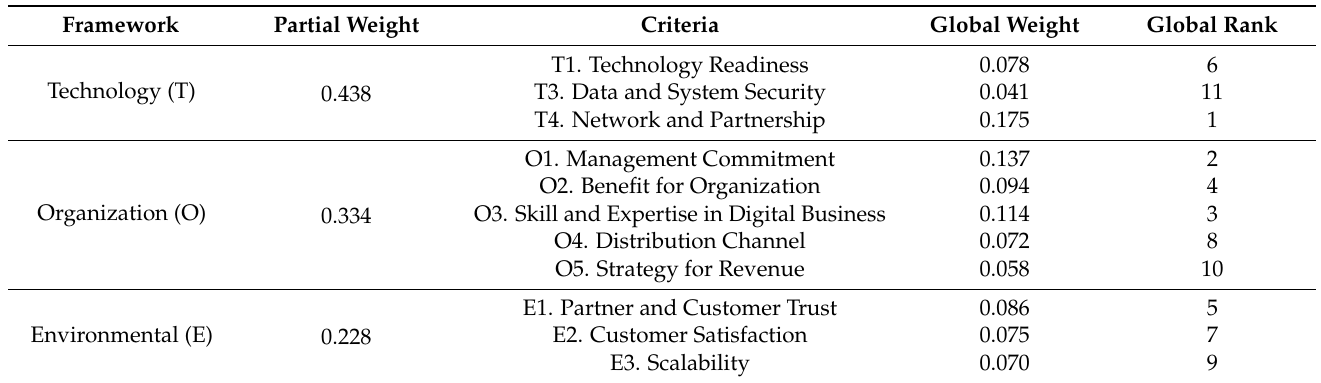
Table 3. Global rank of each factor of TOE framework.